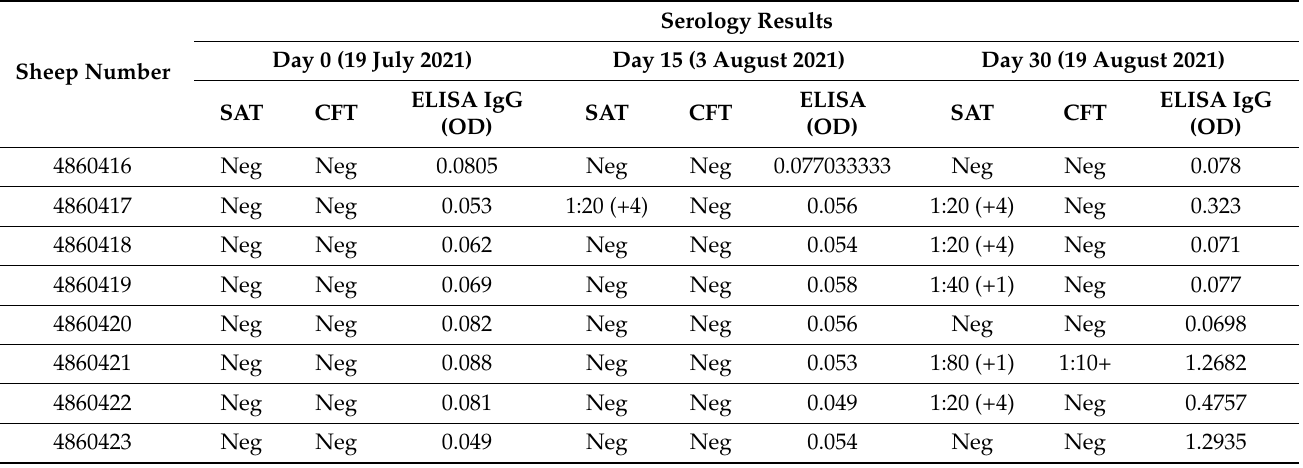
Table 2. Anti- Brucella -OPS serum titers depicted by three serological tests in the second vaccine experiment before and after ocular vaccination with B. melitensis Rev. 1